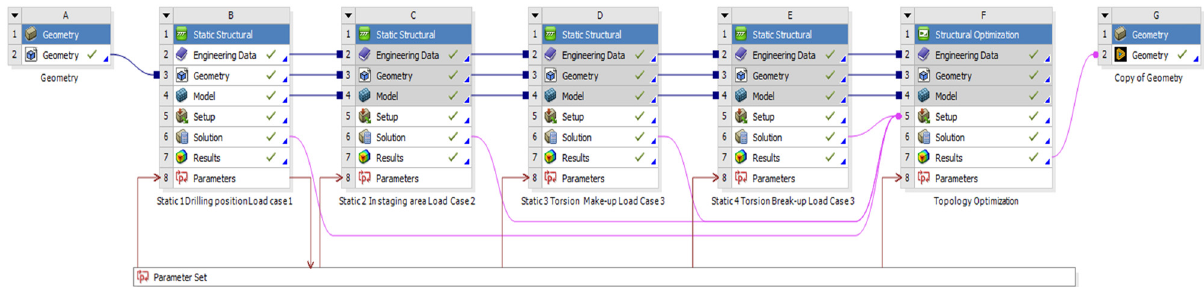
Figure 11: The platform for the multi - loading problem for structural topology optimization within Ansys Workbench.